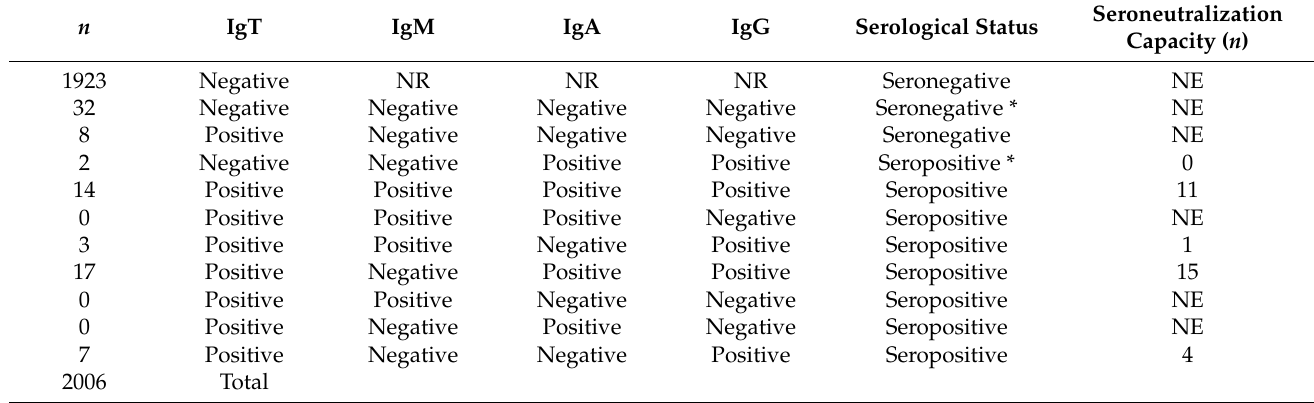
Table 1. Detection of anti-SARS-CoV-2 total immunoglobulin (IgT) antibodies, determination of Ig isotypes and sero- neutralization of seropositive